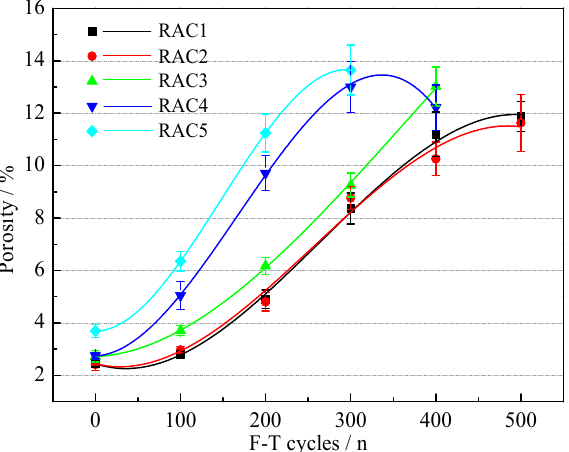
Figure 12. The variations of porosity of RAC-